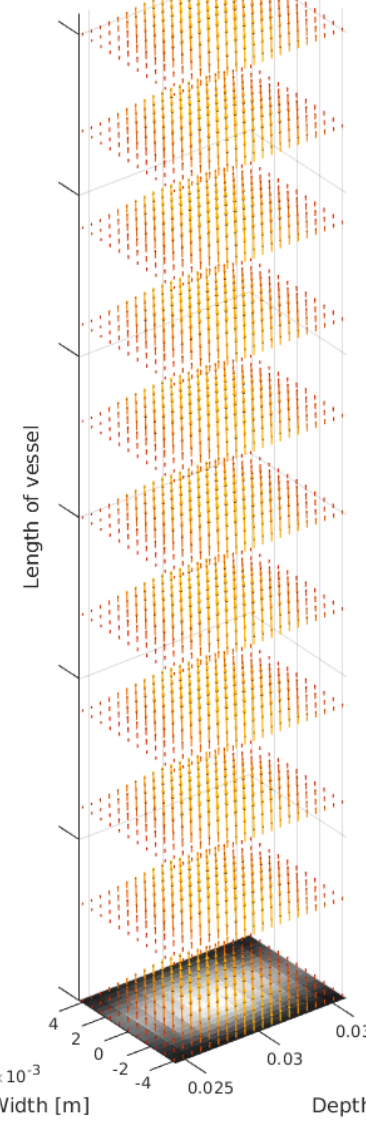
Figure 1. Example of a tensor velocity image. Arrows show the 3D velocity vector in each sample in the volume. The volume is sampled in 11 planes, each plane providing a cross-sectional view of a vessel with laminar